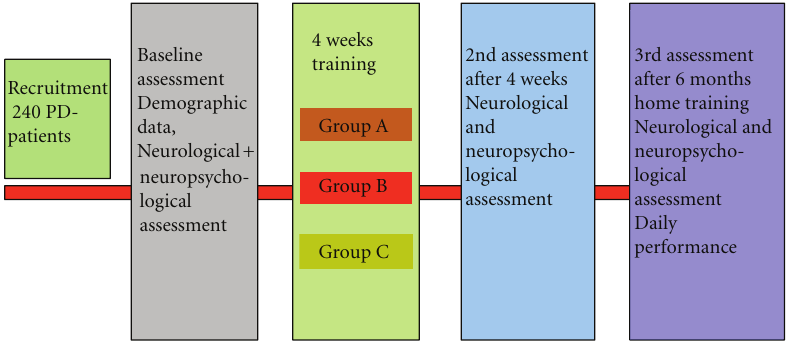
Figure 1: Study design group A: Cognitive training; group B: Cognitive + transfer training, group C: Cognitive, transfer + motor